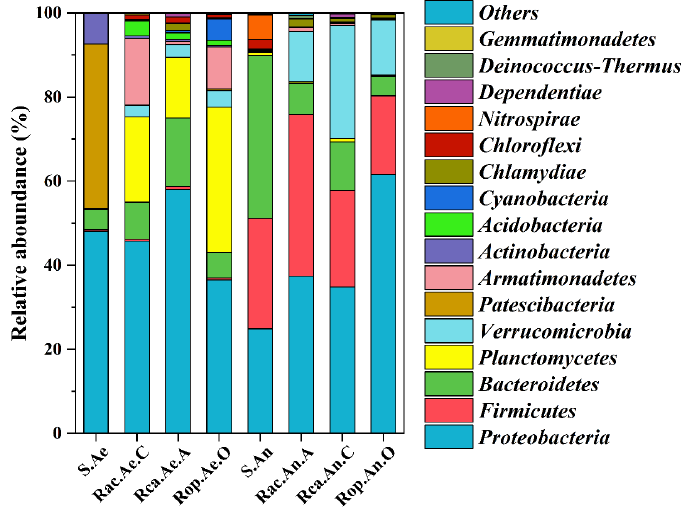
Figure 4. Relative abundances of bacterial community composition in eight samples at the phylum level, for aerobic and anaerobic zones. S.Ae and S.An were collected from initial aerobic and anaerobic sludge; Rac.Ae.C, Rca.Ae.A, and Rop.Ae.O were collected from the aerobic zones of Rac, Rca, and Rop; Rac.An.A, Rca.An.C, and Rop.An.O were collected from the anaerobic zones of Rac, Rca, and Rop, respectively.